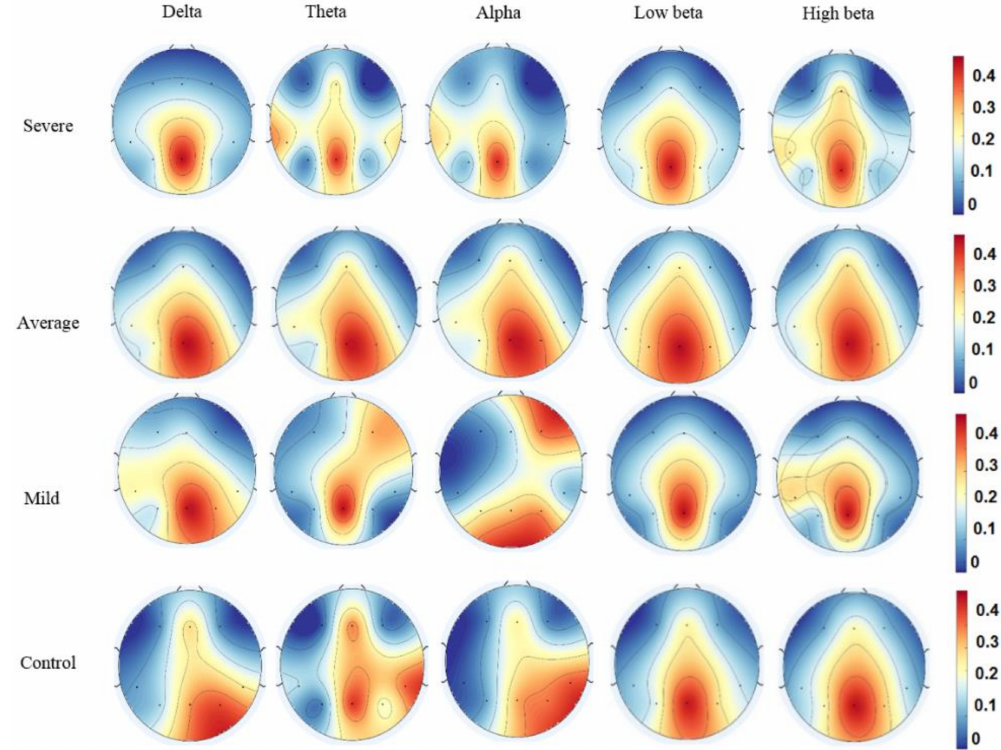
Figure 4. Topological maps of the mean total information intensity for all four SAD groups in the frequency bands. Red indicates greater PDC values; blue indicates a smaller